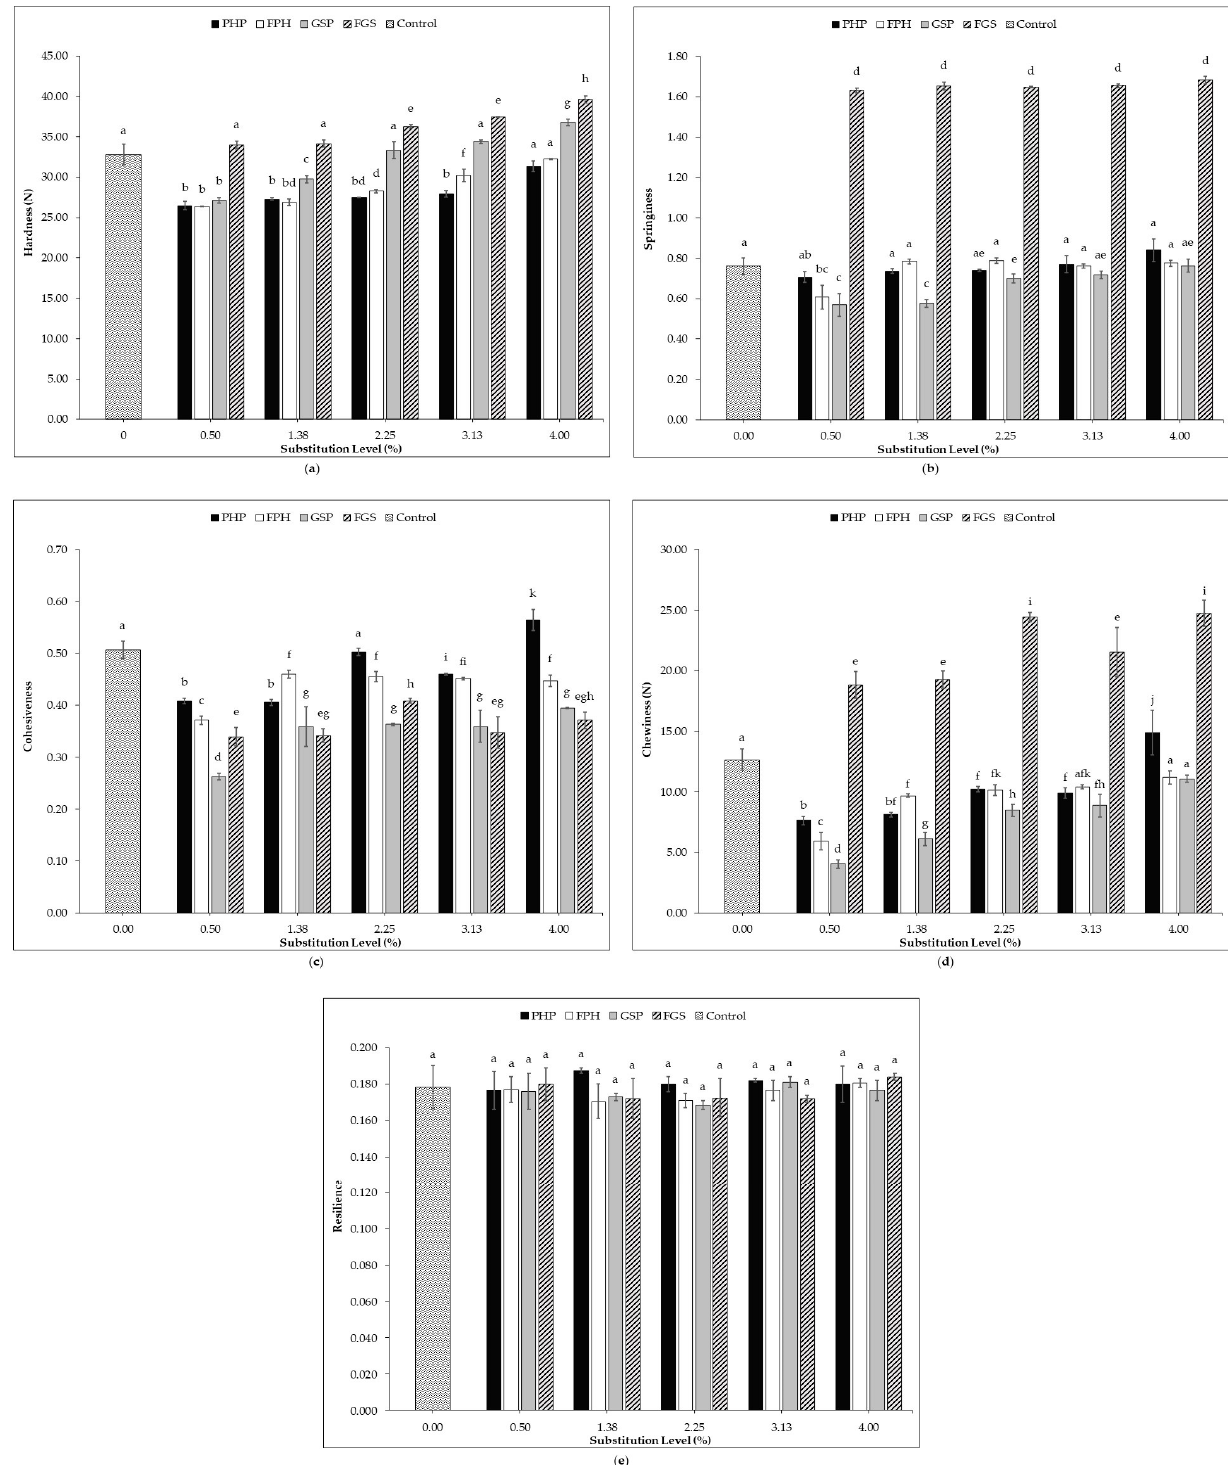
Figure 3. Hardness ( a ), springiness ( b ), cohesiveness ( c ), chewiness ( d ), and resilience ( e ) of the con- trol and enriched breads. Values of each parameter with the same letters were not significantly dif- ferent ( p > 0.05).